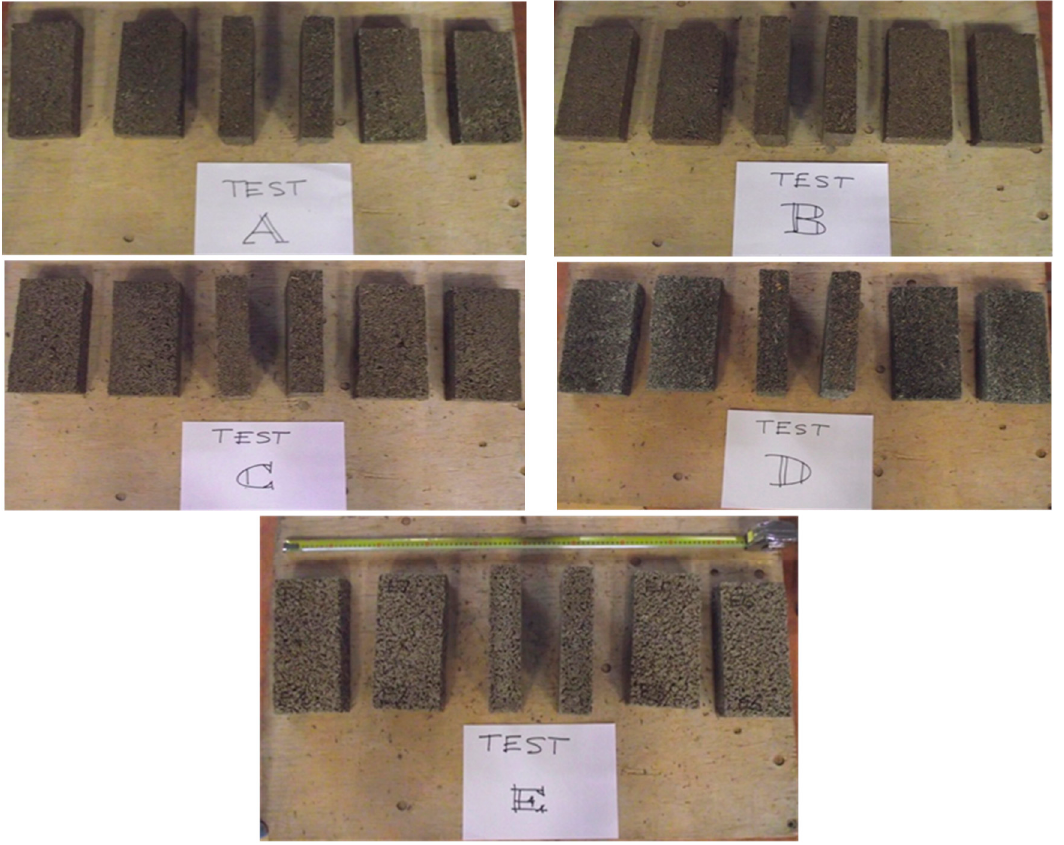
Figure 6. Specimens subjected to mechanical tests. Buildings 2016 , 6 , 40